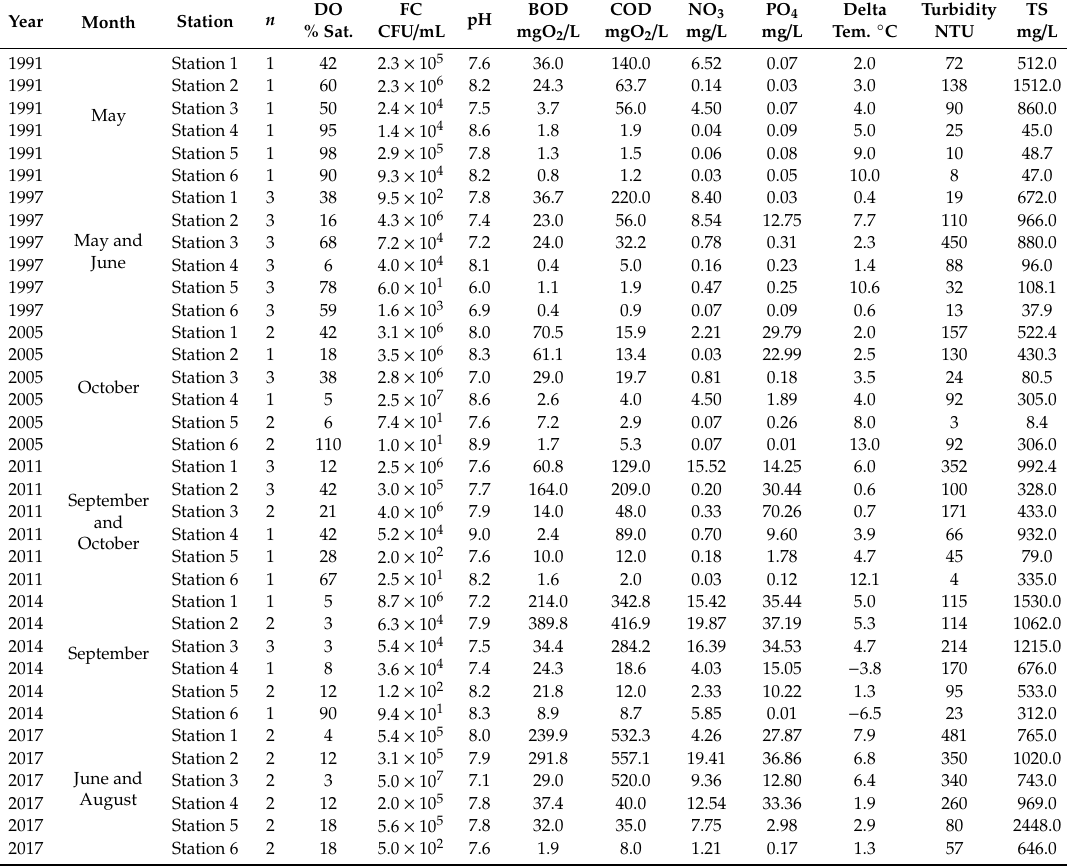
Table 6. Dataset (averages per year and station) collected in former studies (1991 to 2014) and the current study (2017): dissolved oxygen (DO), faecal coliforms (FC: colony-forming units (CFU)), pH, biological oxygen demand (BOD), chemical oxygen demand (COD), nitrates (NO 3 ), phosphates (PO 4 ), delta temperature, turbidity, and total solids (TS).